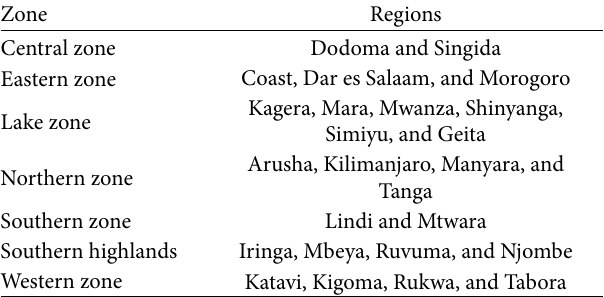
Table 1: Geo-political zones in